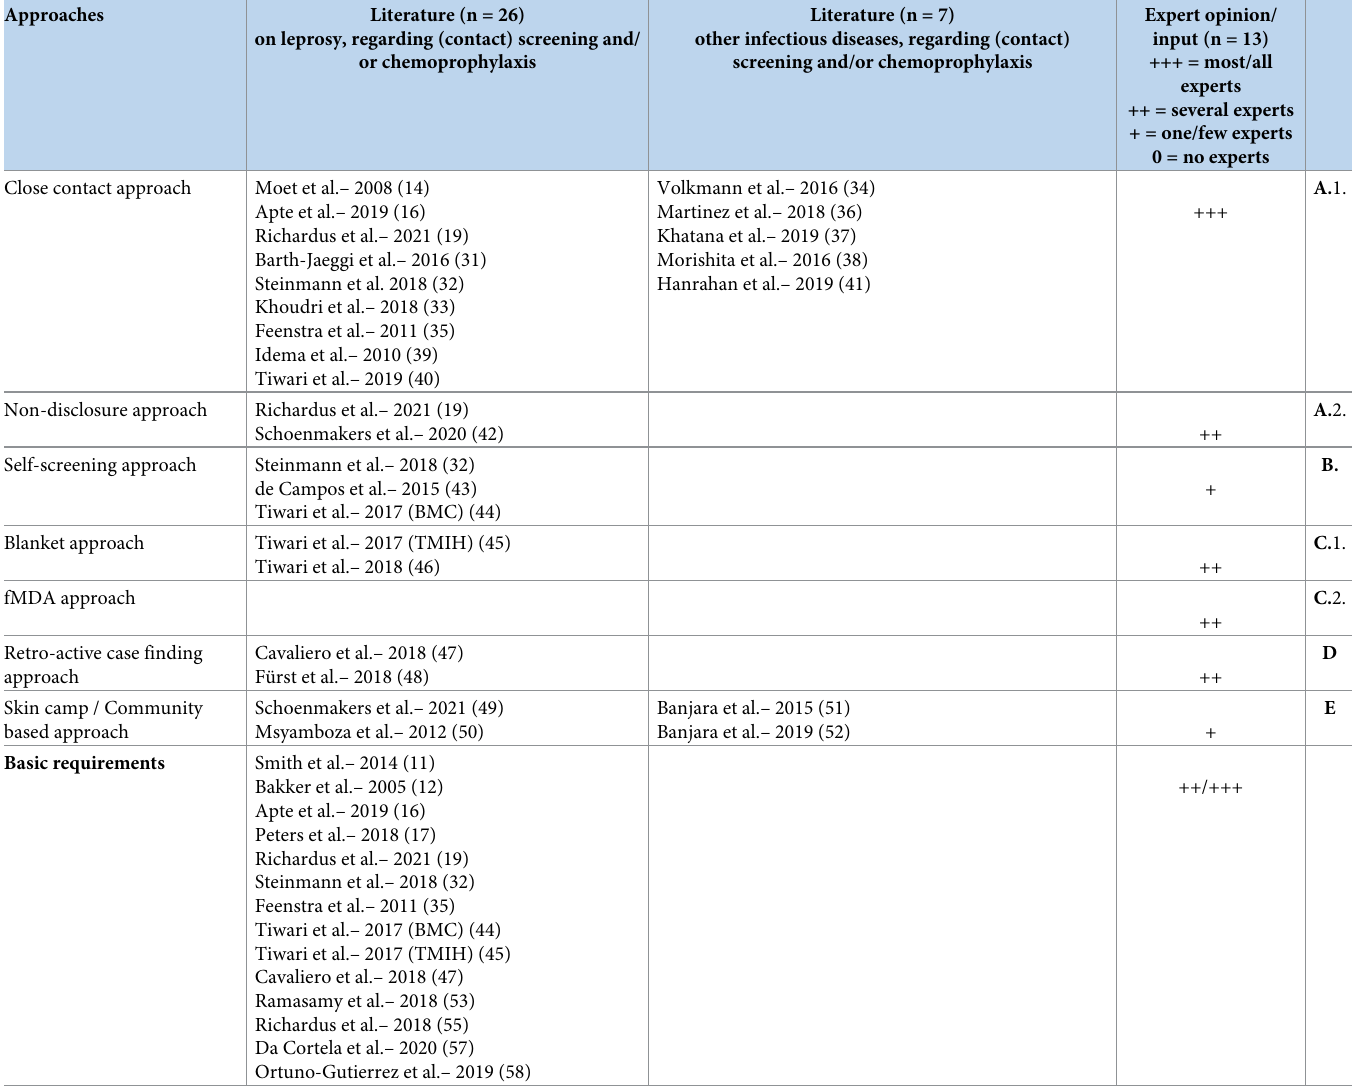
Table 2. Sources used for the identification of approaches and basic